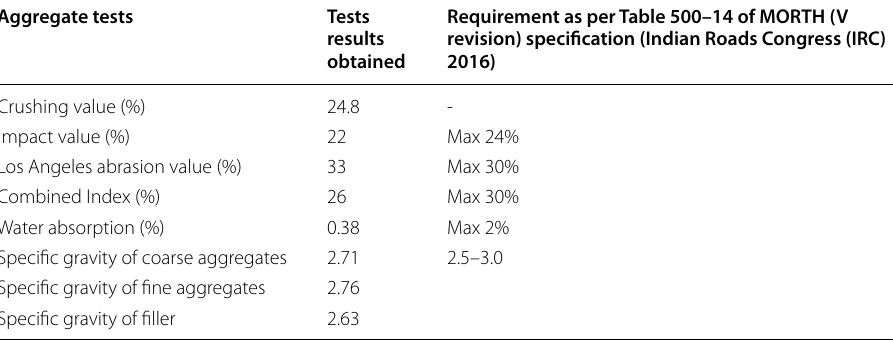
Fig. 2 Environmental advantages of using PET in the design of new pavements Table 1 Properties of aggregates used in the present